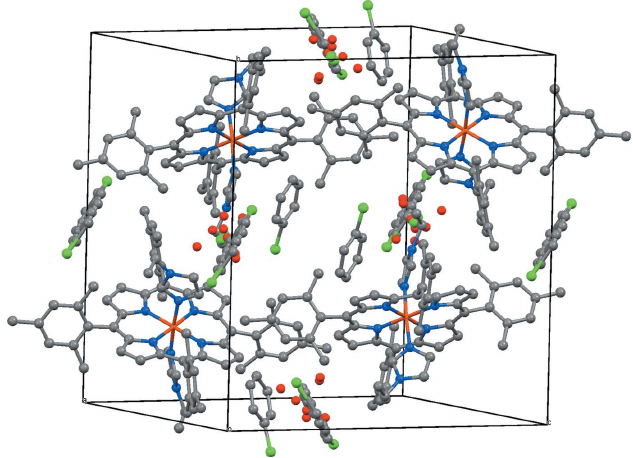
Figure 4 A view of the molecular packing of the title compound. Hydrogen atoms have been omitted for